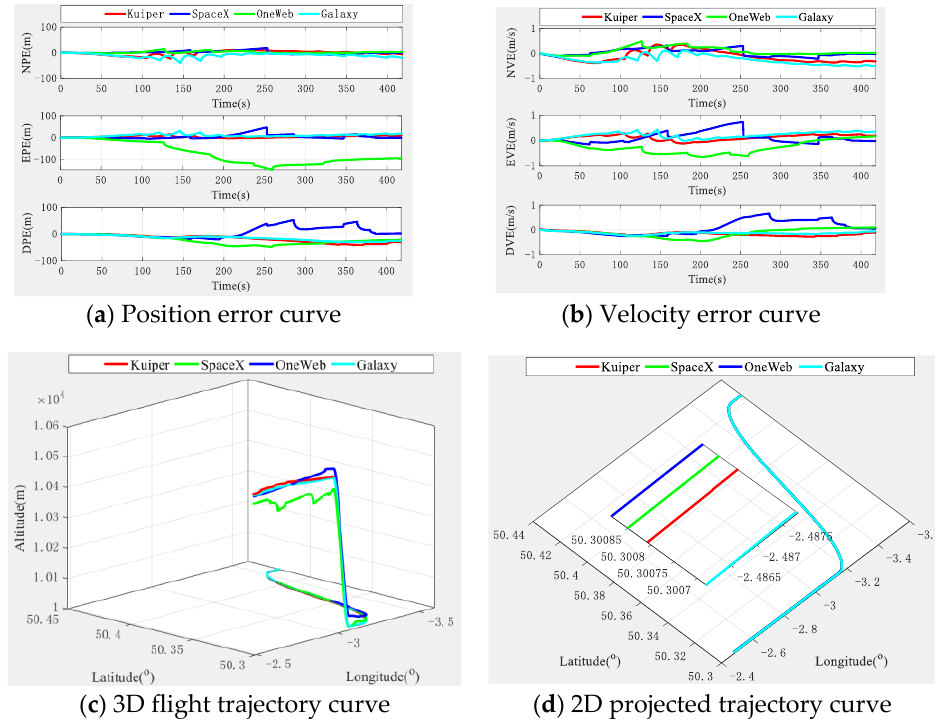
Figure 12. Navigation positioning error curves under different relative measurement accuracy.